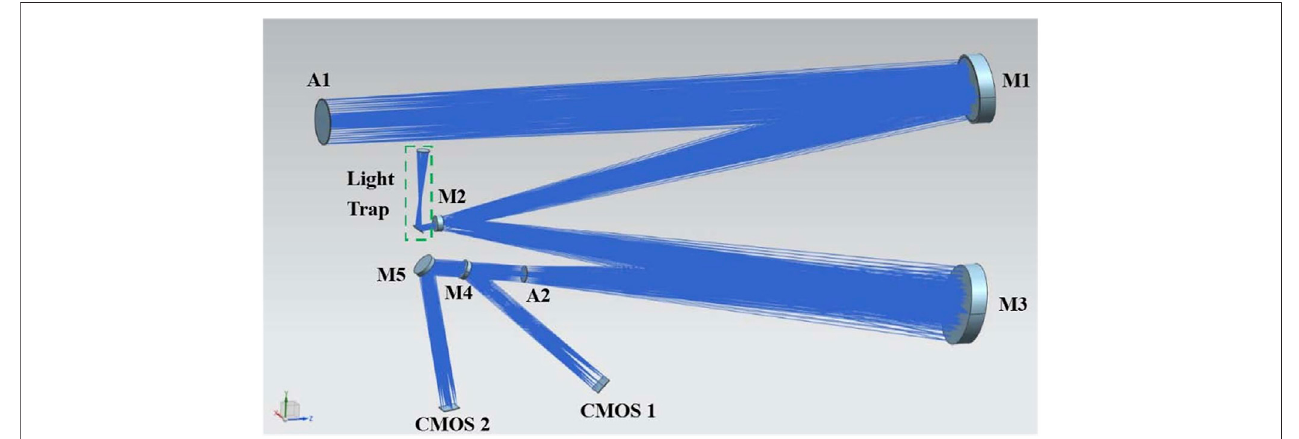
FIGURE 1 | Schematic optical layout of SCI.